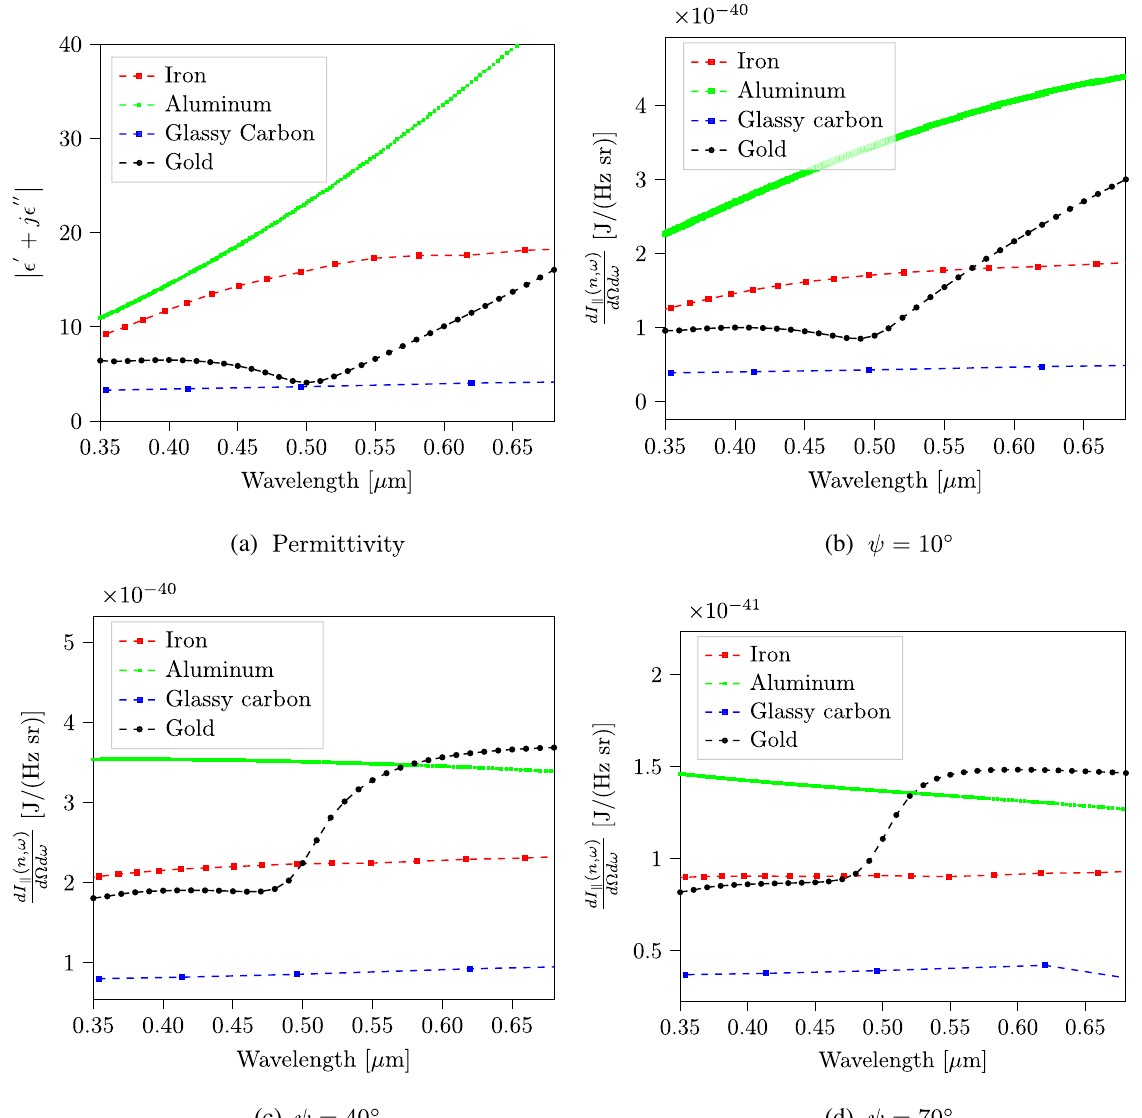
FIG. 19. Optical transition radiation spectra. (a) Shows the variation in absolute value of epsilon in visible range. (b – d) Calculated radiated intensity for different irradiation angles and the observation angle is θ ¼ 90 − ψ